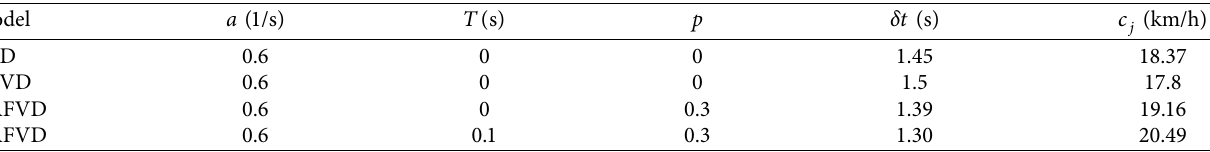
Table 3: Delay time δ t (s) of vehicle motions in a signalized intersection and the velocity of kinematic wave ( c FDV and AAFVD